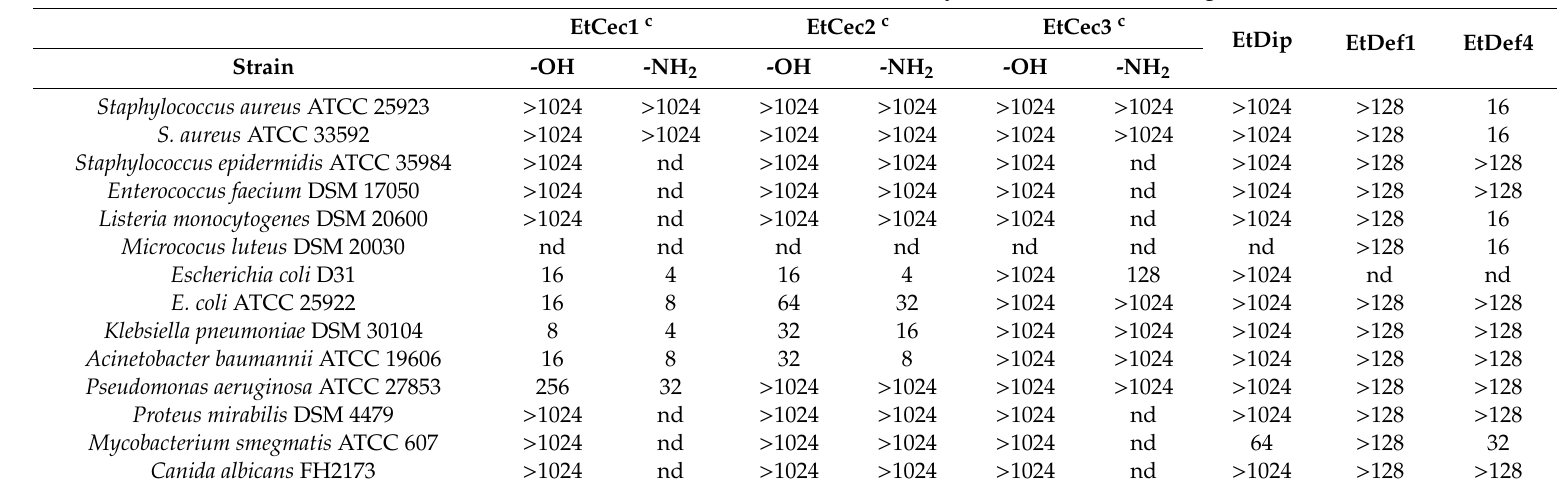
Table 2. Reference strains and the activity of the Eristalis tenax peptides against them. Gray shading = Gram-positive, no shading = Gram-negative; pink shading = acid-fast bacteria and